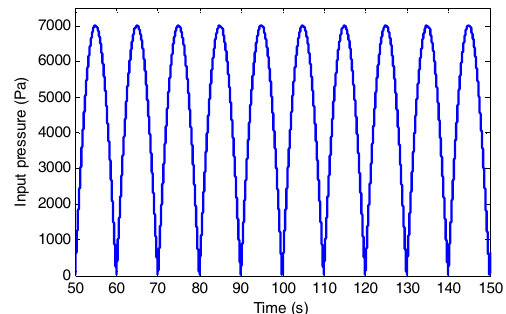
34.50 Figure 7. Comparison of average output power between manual and optimised LUT.